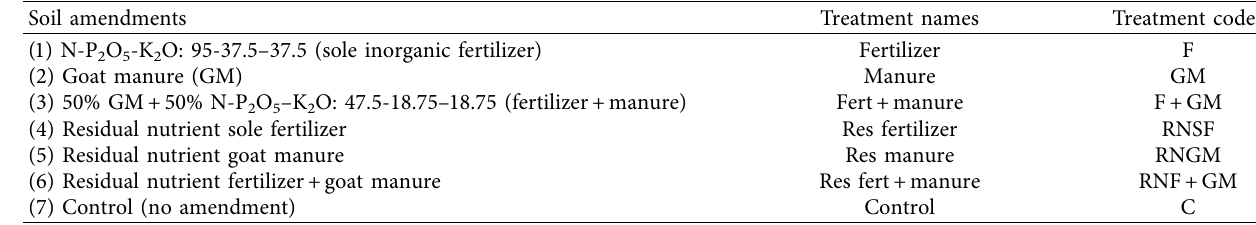
Table 2: Soil amendments and rates used in the minor cropping season 2017.